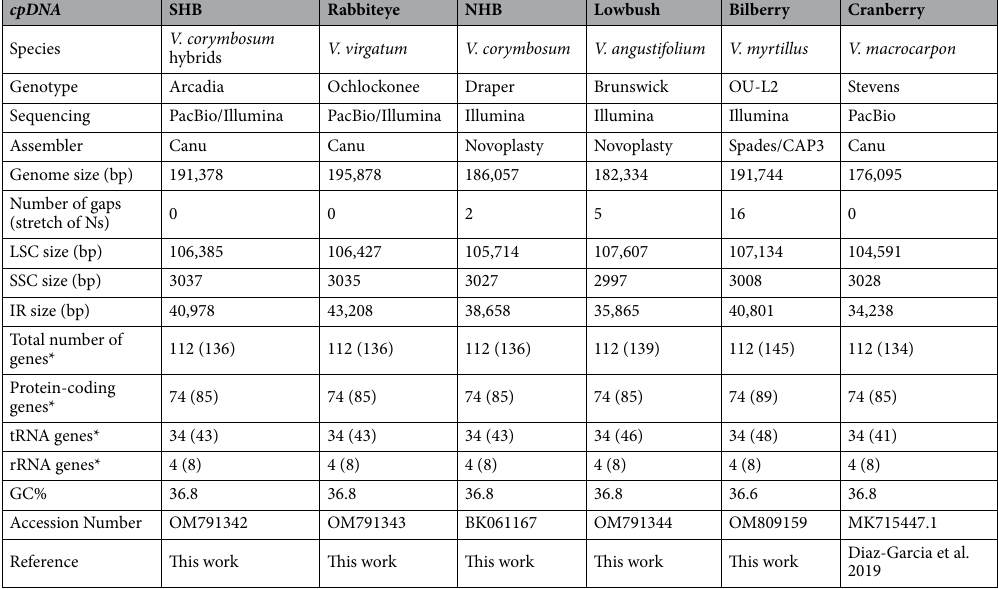
Table 1. Assembly and annotation statistics of the chloroplast genomes from six Vaccinium species. *Number of unique functional genes. In parentheses: Number of genes including